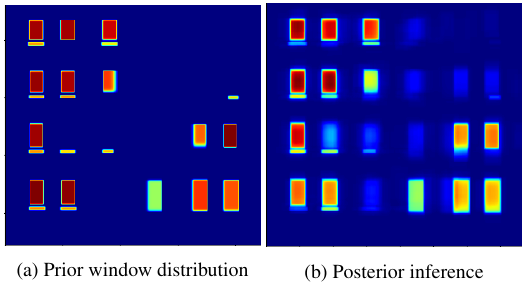
Figure 6. The inference of the occluded windows.